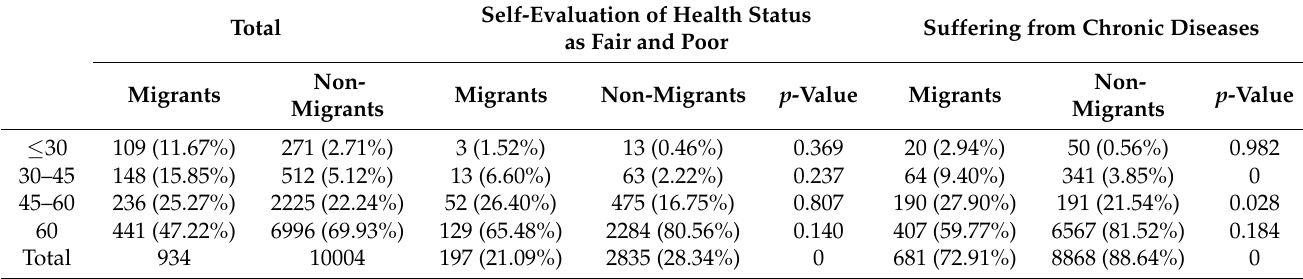
Table 2. The health status of unwell migrants and non-migrants in different age groups.